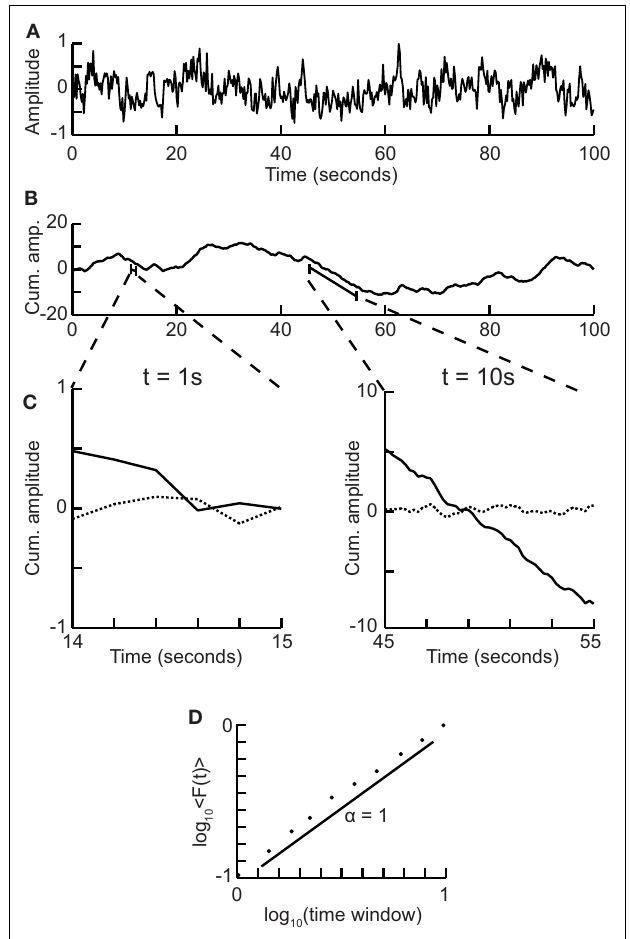
FIGURE 5 | Step-wise explanation of Detrended FluctuationAnalysis. (A) Original time series.Taken from a 1/ f signal sampled at 5Hz with a duration of 100s. (B) Cumulative sum of original signal shows large fluctuations away from the mean. (C) For each window size looked at, remove the linear trend from the signal, and then calculate the fluctuation. Two example window sizes shown with signal shown as solid line, and detrended signal shown as dotted line. (D) Plot the mean fluctuation per window size against window size on logarithmic axes.The DFA exponent is the slope of the best-fit line ( α =